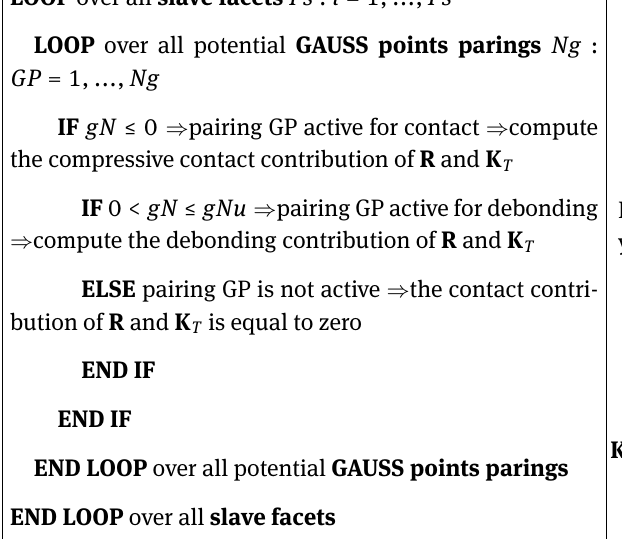
LOOP over all slave facets Fs : i = 1, ..., Fs LOOP over all potential GAUSS points parings Ng : GP = 1, ...,